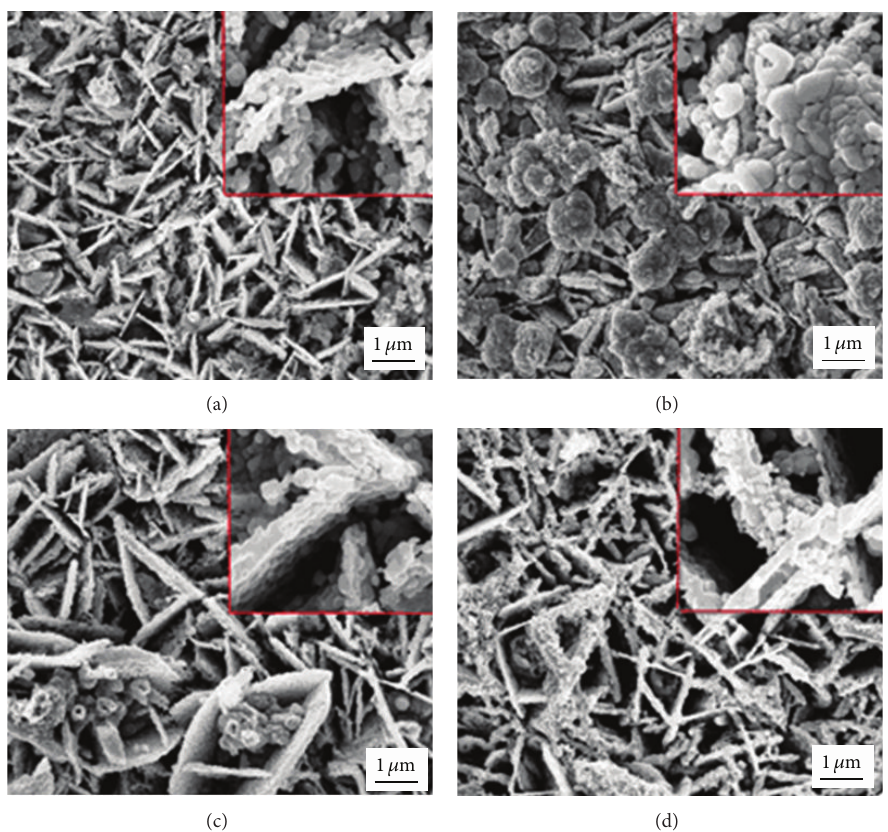
Figure 4: SEM images of preparation ZnO under different electrodeposition times: (a) 2 min, (b) 3 min, (c) 4min, and (d) 5 min. Part of the insert of the red box for